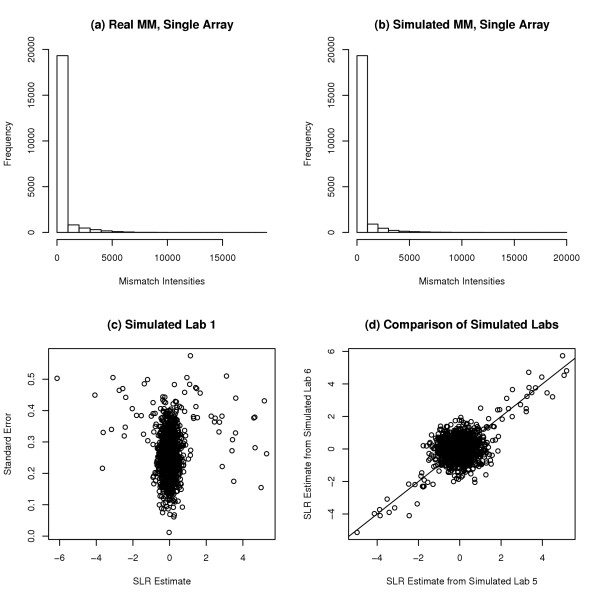
Summary of real and simulated RN_U34 Affymetrix chip data. (a) The real mismatch (MM) intensities are from a RN_U34 Affymetrix chip, and their histogram closely resembles a Gamma distribution with a long tail. (b) The simulated MM intensities are drawn from a Gamma distribution to resemble the real MM intensities. (c) The relationship between the SLR from a simulated lab and the standard error of the SLR for each gene on the RN_U34 Affymetrix chip. Large absolute SLR's with small standard errors indicate significant differential expression. (d) A comparison of SLR estimates from two simulated labs shows general agreement, with some differences between labs.